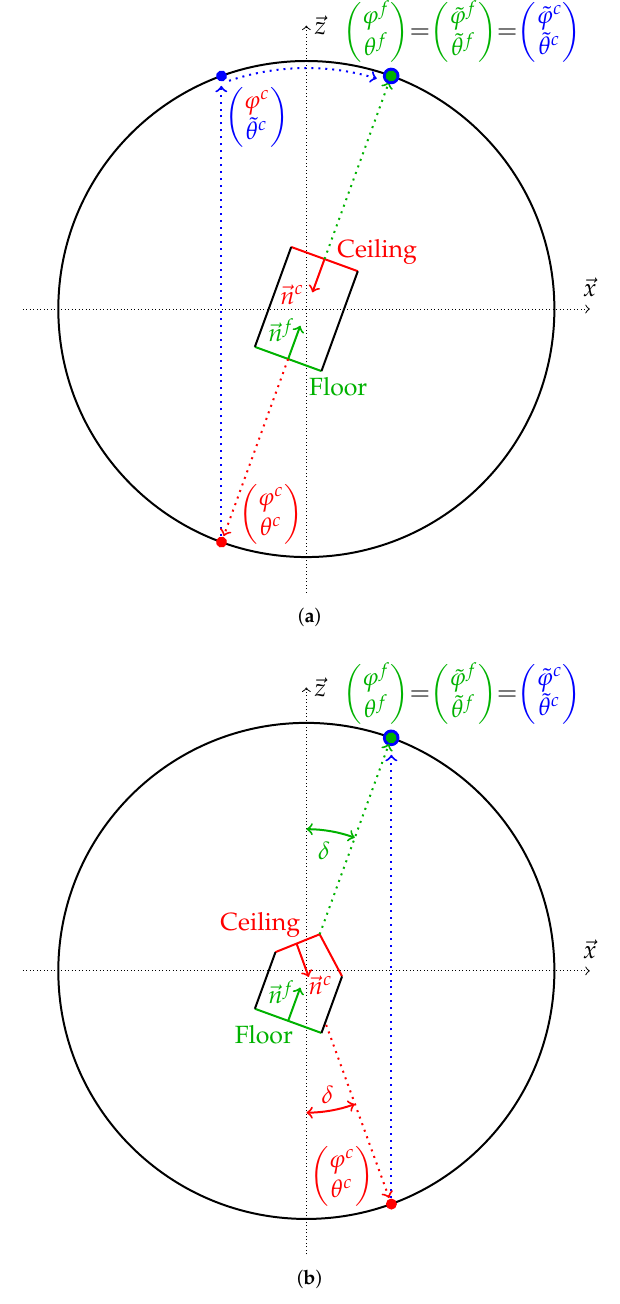
Figure 10. Transformation of ( ϕ , θ ) positions on the whole unit sphere to ( ˜ ϕ , ˜ θ ) positions on one- eighth of the unit sphere by Equations (13) and (14). ( a ) Generally, points corresponding to opposing normal vectors are transformed to the same point. ( b ) In case the vertical axis (cid:126) z is the angle bisector between the directions of two normal vectors (same angle δ to the (cid:126) z axis), these are transformed to the same point even if they are not opposed. This needs to be dealt with by means of a cluster analysis per ( ˜ ϕ , ˜ θ ) grid